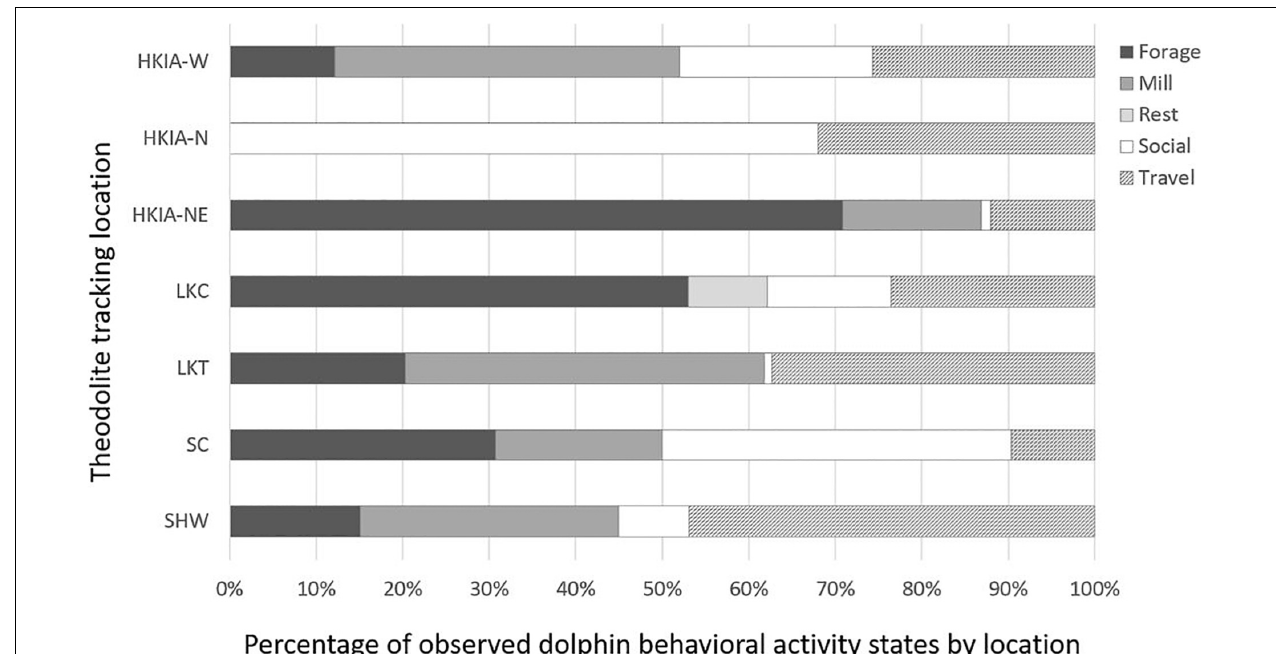
FIGURE 7 | Stacked bar graph showing behavioral activity state percentages of Indo-Pacific humpback dolphins off Hong Kong, based on theodolite tracking